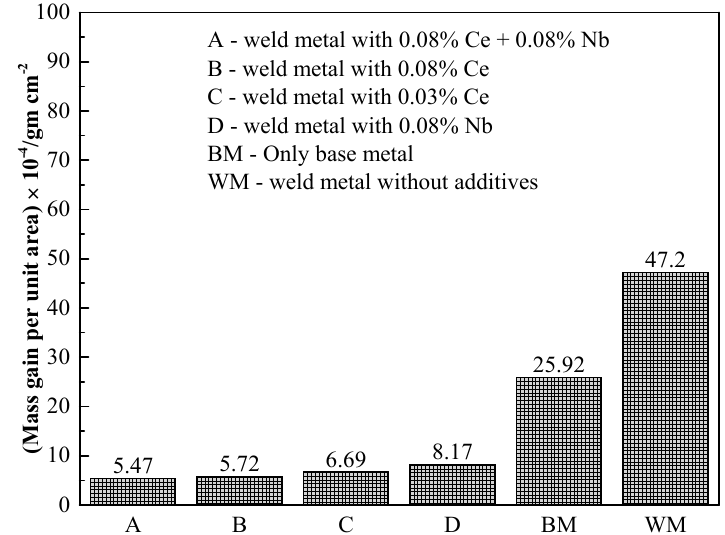
and ( b ) weld center [50].